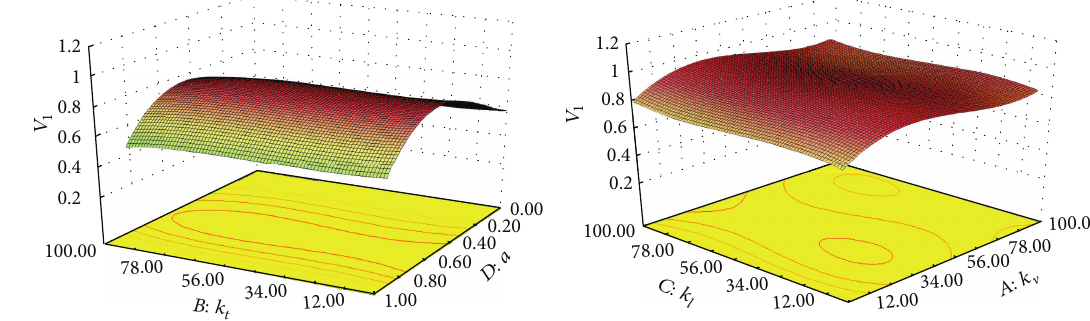
Figure 7: The response surface model of first vertical mode shape.